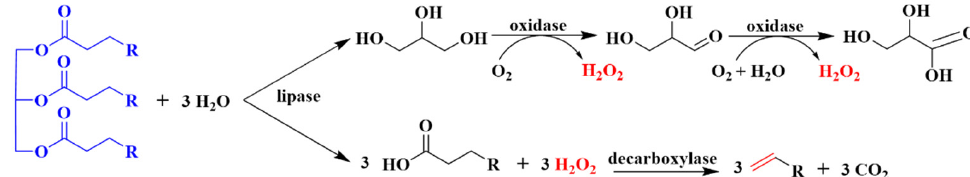
Figure 7. One-pot enzymatic production of hydrocarbons (adapted from [213]). Exogenous addition of glycerol may be employed to solve the shortage of one equivalent of H 2 O 2 .